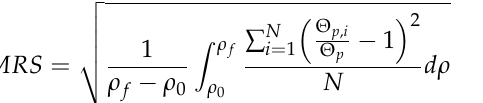
Figure 3. ( a ) Construction of the ρ -log( Θ ) curves with different apparent densification activation energy. ( b ) Mean residual squares of the master sintering curve for different Q values.